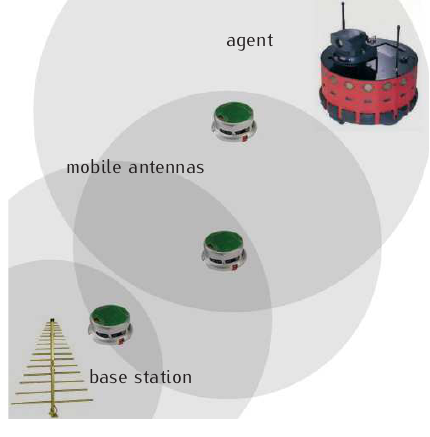
Figure 11. Sketchofthecoverageproblemtobesolved; theautonomousagent needs to be connected with the base station by the use of a platoon of mobile antennas.